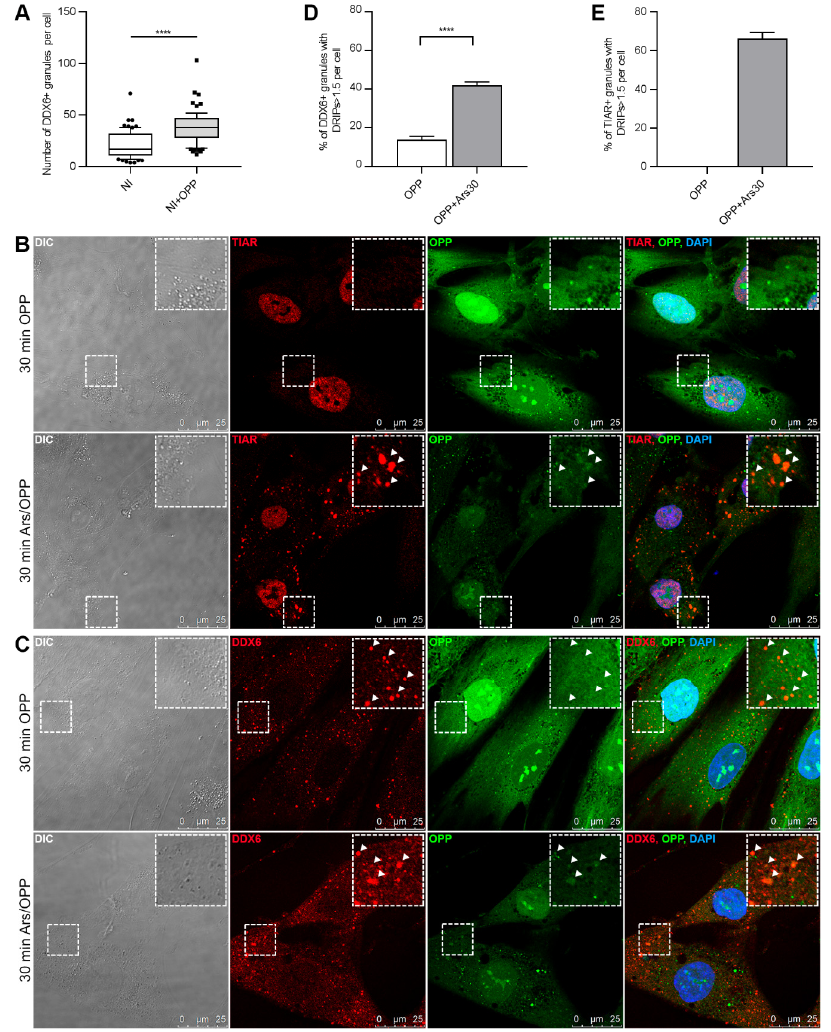
Figure 3. DDX6 granule assembly was regulated by translational activity. ( A ) Quantification of the mean number of DDX6 granules per cell before (NI) and after treatment of the hASCs with o-propargyl puromycin (OPP) (NI + OPP). Seventy cells per condition were analyzed ( n = 70). Quartile 10–90%; Mann-Whitney test: **** p < 0.0001. ( B ) Images from immunofluorescence analysis by confocal microscopy of TIAR and DRIP localization in the hASCs treated with OPP only (30-min OPP) or OPP and sodium arsenite (30-min Ars / OPP). SGs containing TIAR showed accumulated DRIPs but only under stress conditions. White arrows: granules. Nuclei were stained with DAPI. ( C ) Results from immunofluorescence analysis by confocal microscopy of DDX6 and DRIP localization in the hASCs treated with OPP only (30 min of OPP incubation) or OPP and sodium arsenite (30 min of Ars / OPP incubation). DDX6 granules were found under both stress and nonstress conditions; however, they accumulated DRIPs only after stress induction. White arrows: granules. Nuclei were stained with DAPI. ( D ) Quantification of DDX6 granules enriched with DRIPs in the hASCs treated with only OPP (OPP) or with OPP and sodium arsenite (OPP + Ars30). The bar graph shows the percentages of DDX6 granules enriched with DRIPs (granule / surrounding region signal ratio > 1.5) per cell. At least 34 cells were analyzed per condition; standard error of the mean (SEM); Mann-Whitney test: **** p < 0.0001. ( E ) Quantification of TIAR granules enriched with DRIPs in the hASCs treated with only OPP (OPP) or OPP and sodium arsenite (OPP + Ars30). The cells treated with only OPP did not have assembled TIAR granules. The bar graph shows the percentages of TIAR granules enriched with DRIPs (granule / surrounding region signal ratio > 1.5) per cell. Thirty-two cells were analyzed; standard error of the mean